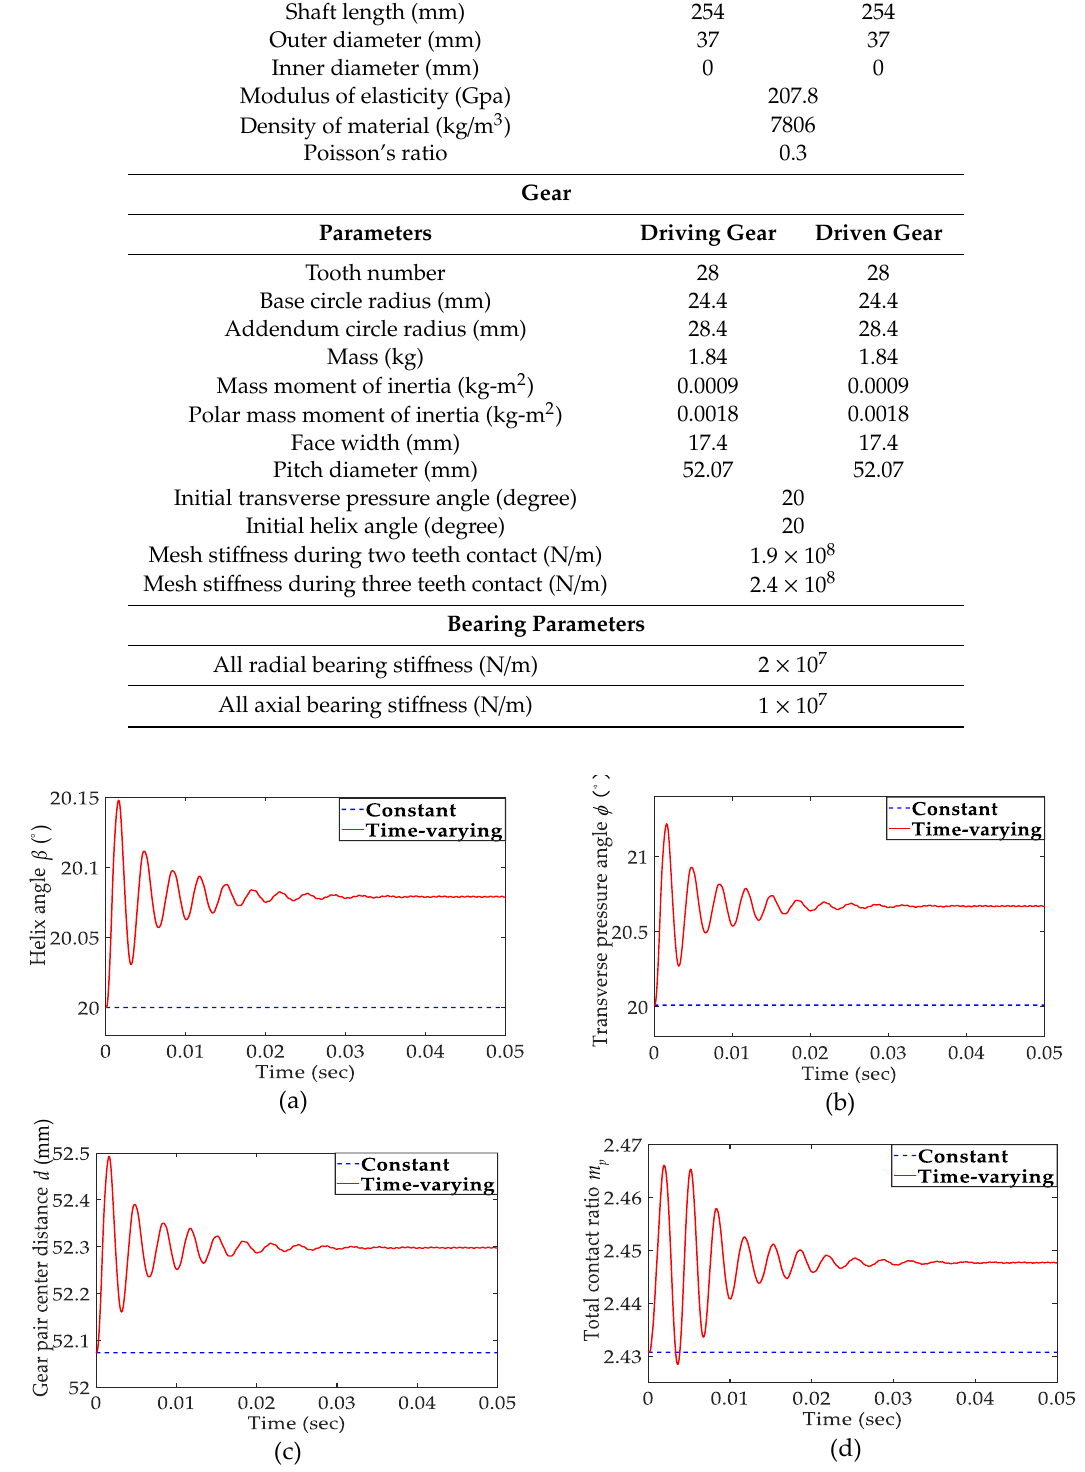
Figure 6. Time-varying and constant (a) helix angle, (b) transverse pressure angle, (c) gear pair center distance, and (d) total contact ratio.